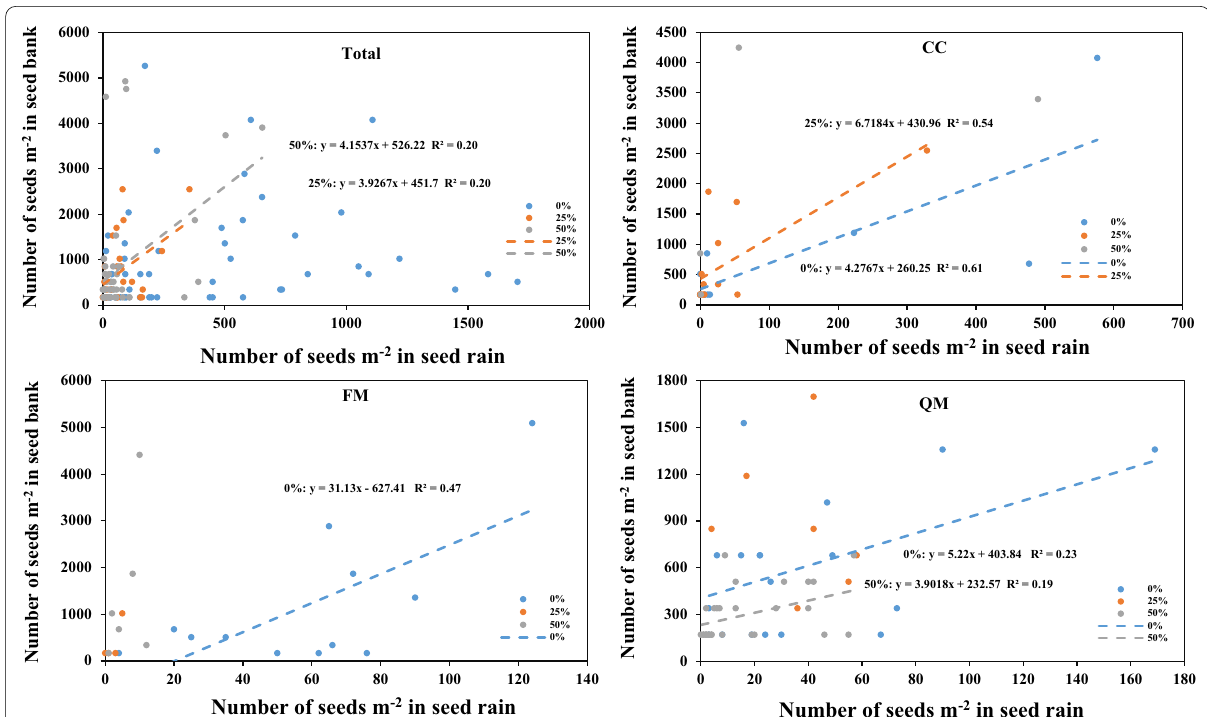
Fig. 5 Relationships between seed density of seed rain and that of soil seed bank for all woody species (Total) and for Cornus controversa (CC), Fraxinus mandshurica (FM), and Quercus mongolica (QM) for the control (0%), 25% (25% of the basal area removal), and 50% (50% of the basal area removal) logging intensities in October 2018